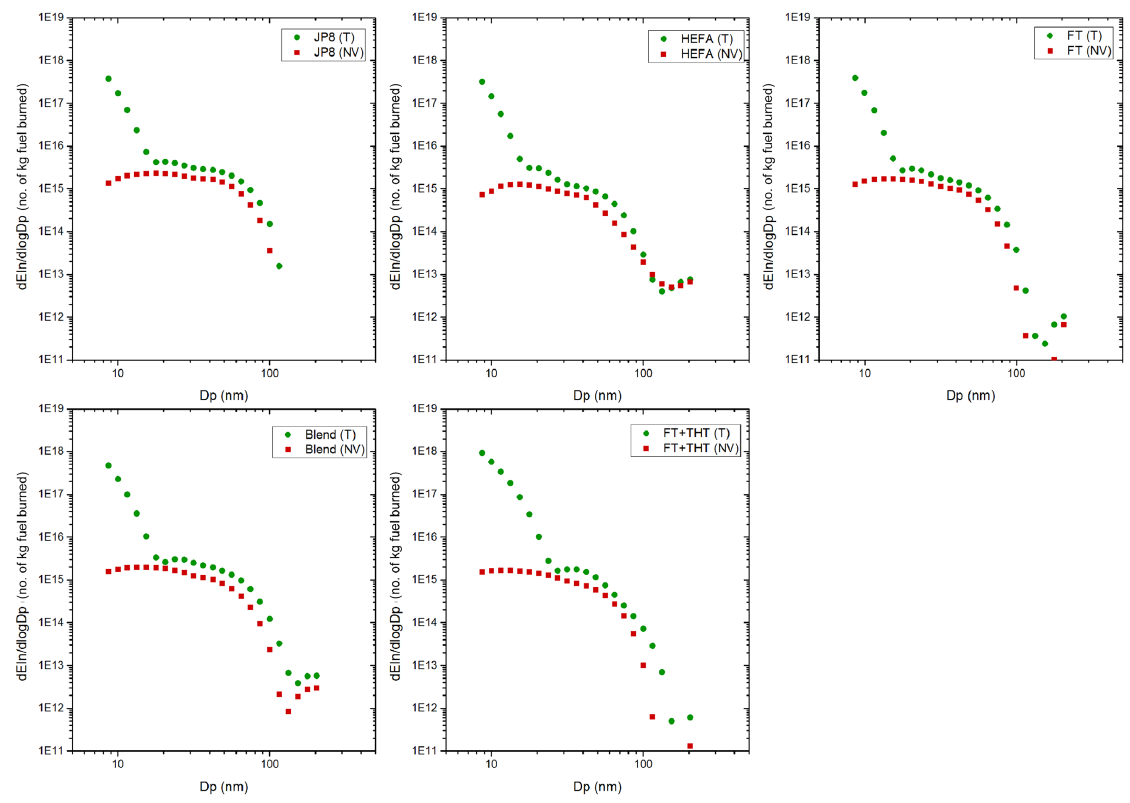
Figure 7. Total (T) and non-volatile (NV) PM number-based emission index (EI n ) size distributions for the various fuels at the 100% engine thrust